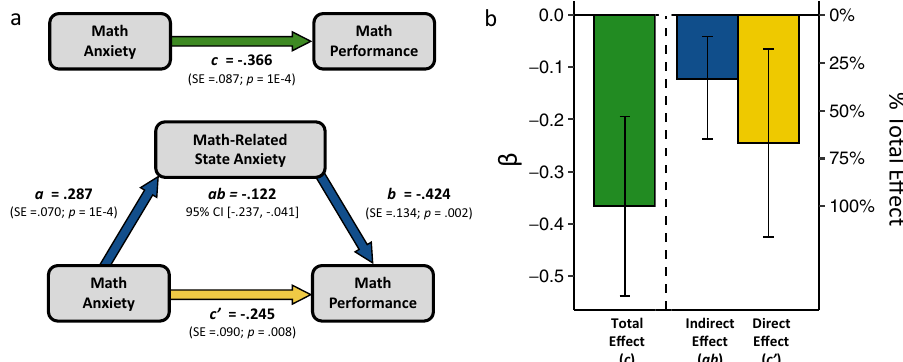
Fig. 2 Mediating effect of math-related state anxiety on the math anxiety-performance link. ( a ) shows a mediation model that assesses the extent to which math-related state anxiety mediates the association between math anxiety and math performance. General anxiety, word task performance, and word task-related anxiety were controlled for. ( b ) visualizes the magnitudes of the total effect of math anxiety on math performance, the indirect effect of math anxiety on math performance through math-related state anxiety (i.e., the extent to which math- related state anxiety explains the math anxiety-performance association), and the direct effect of math anxiety on math performance independent of math-related state anxiety (i.e., the extent to which the math anxiety-performance association cannot be explained by math- related state anxiety). Error bars represent 95% con fi dence